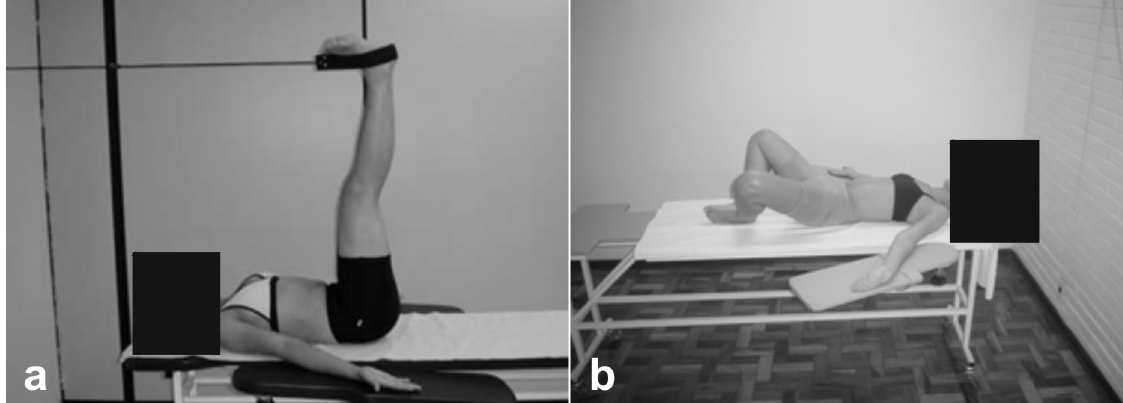
Figure 1 - Global posture reeducation stretching positions: a) posterior muscle chain stretching; b) anterior muscle chain